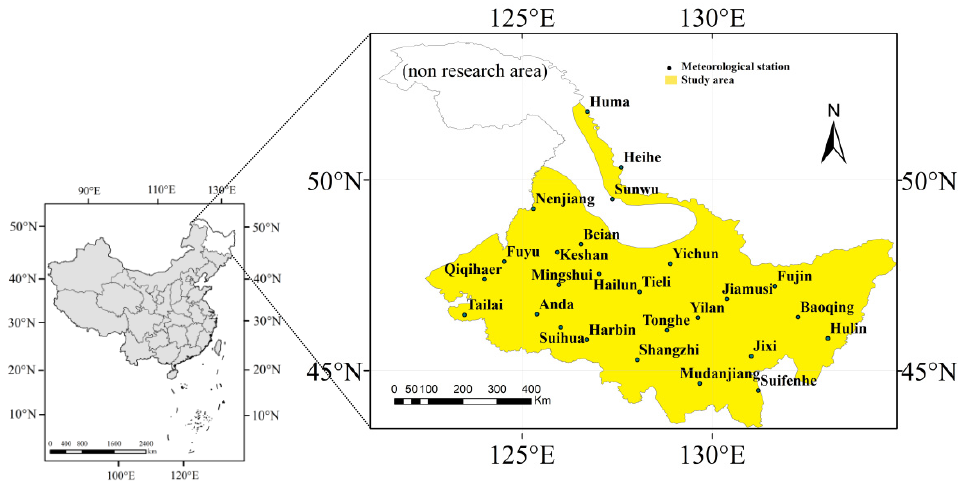
Figure 1. Locations of the Heilongjiang Province and 26 meteorological stations.